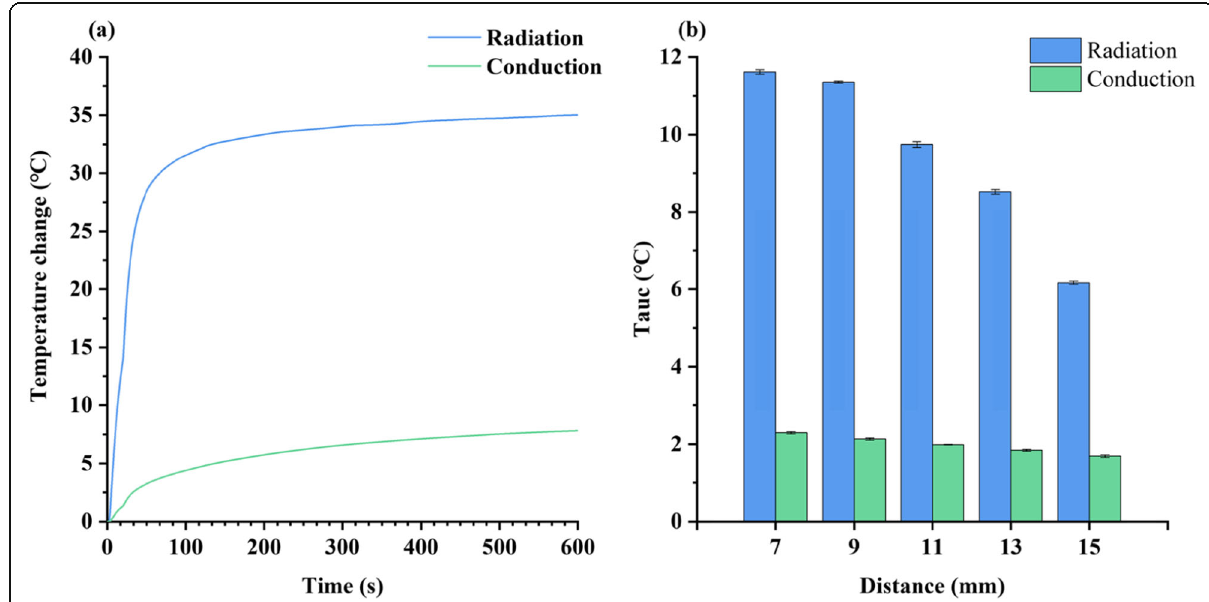
Fig. 3 Thermal sensing optimization. a Temperature changes in 10 min irradiation. b Thermal signal at different irradiation